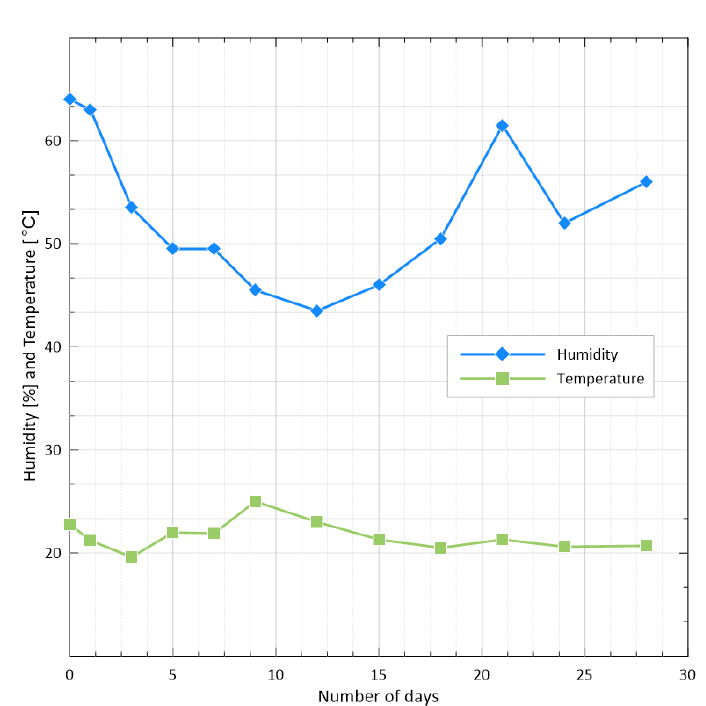
Figure 5. Temperature and humidity during shrinkage